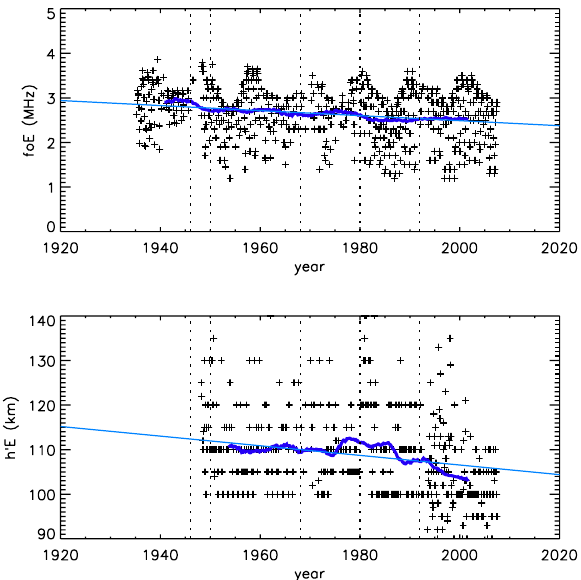
Fig. 4. Trends in f oE 0 (upper panel) and h 0 E 0 (lower panel). Indi- vidual symbols show the monthly mid-day medians (as in Fig. 1.); thick green lines: smoothed time series; thin blue lines: ± 1-sigma limits to the linear fits to the smoothed data obtained from the mean standard deviation of the individual absolute deviations in the linear fits shown in Fig. 2; vertical dotted lines indicate dates when system changes were made. The trends are as follows: f oE 0 , −